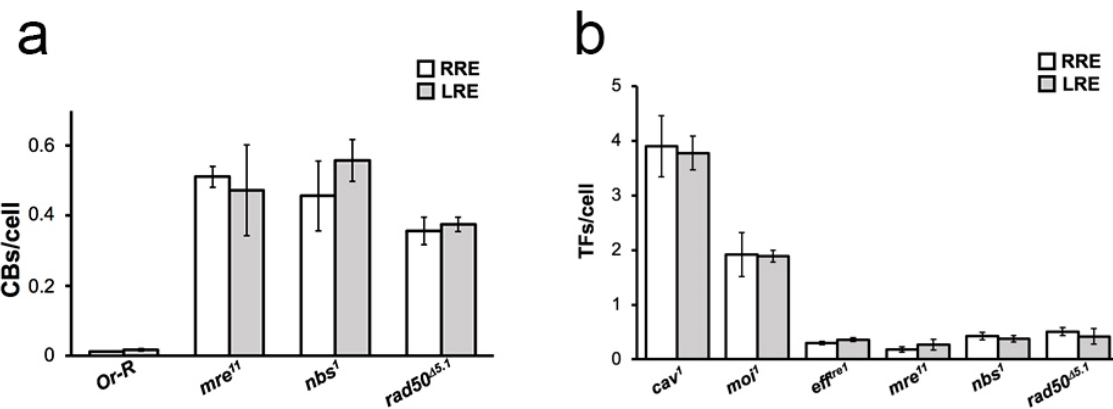
Figure 3. Effects of the deprivation of the radiation background on DDR and telomere capping mutants. ( a ) Analysis of Chromosome Breaks (CBs) in DNA damage response (DDR) mutants. The values refer to the frequency of spontaneous CBs of Drosophila mre11 , nbs1 , and rad50 D5.1 mutants maintained for five generations and RRE. No statistically significant differences were observed in LRE compared to RRE ( t -test). ( b ) Analysis of Telomere Fusions (TFs) in telomere capping and DNA damage response (DDR) mutants. The graph shows the frequency of TFs obtained by counting double telomere associations (DTAs) and single telomere associations (STAs) in Drosophila strains mutated in genes encoding telomere capping proteins ( cav 1 , moi 1 , and eff tre 1 ) and DNA damage repair factors ( mre 11 , nbs 1 , and rad50 D 5.1 ) maintained for five generations at LRE and RRE. No statistically significant differences were observed between LRE and RRE ( t -test). CBs: Chromosome Breaks; TFs: